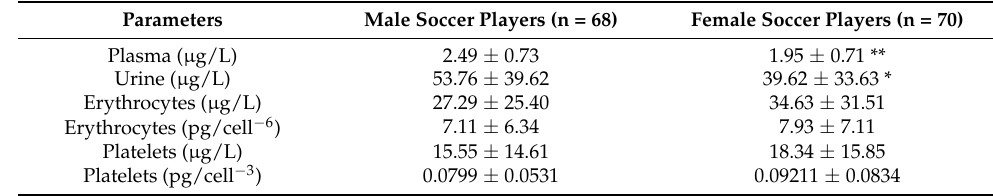
Table 5. Mo concentrations in the different biological matrices analyzed.